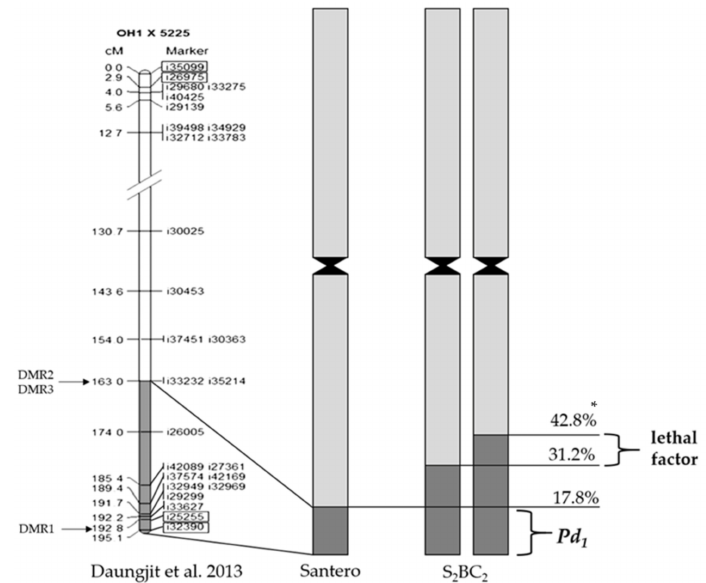
Figure 4. The integrated recombination [23] and physical maps for the S 2 BC 2 recombinant A. cepa × A. roylei chromosome 3. DMR1: the marker linked to downy mildew resistance gene; DMR2 and DMR3: the recombinant selection markers, which were produced by Kim et al. [22]. Loci used by Kim et al. [22] in the identification of the position of the resistance gene are enclosed in rectangular boxes. * Position of recombination site is the ratio of the length of the distance between distal end of chromosome arm and recombination site to the total length of the arm